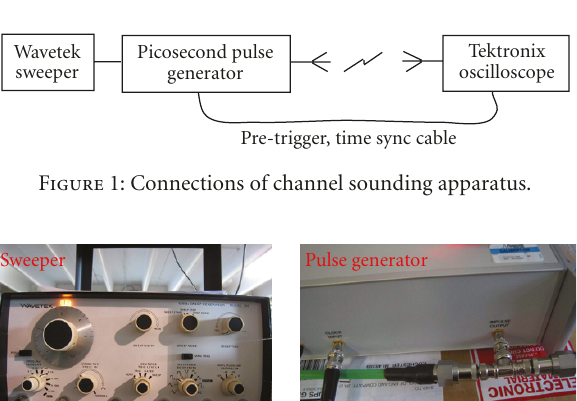
Figure 3: Parking building and a test vehicle.